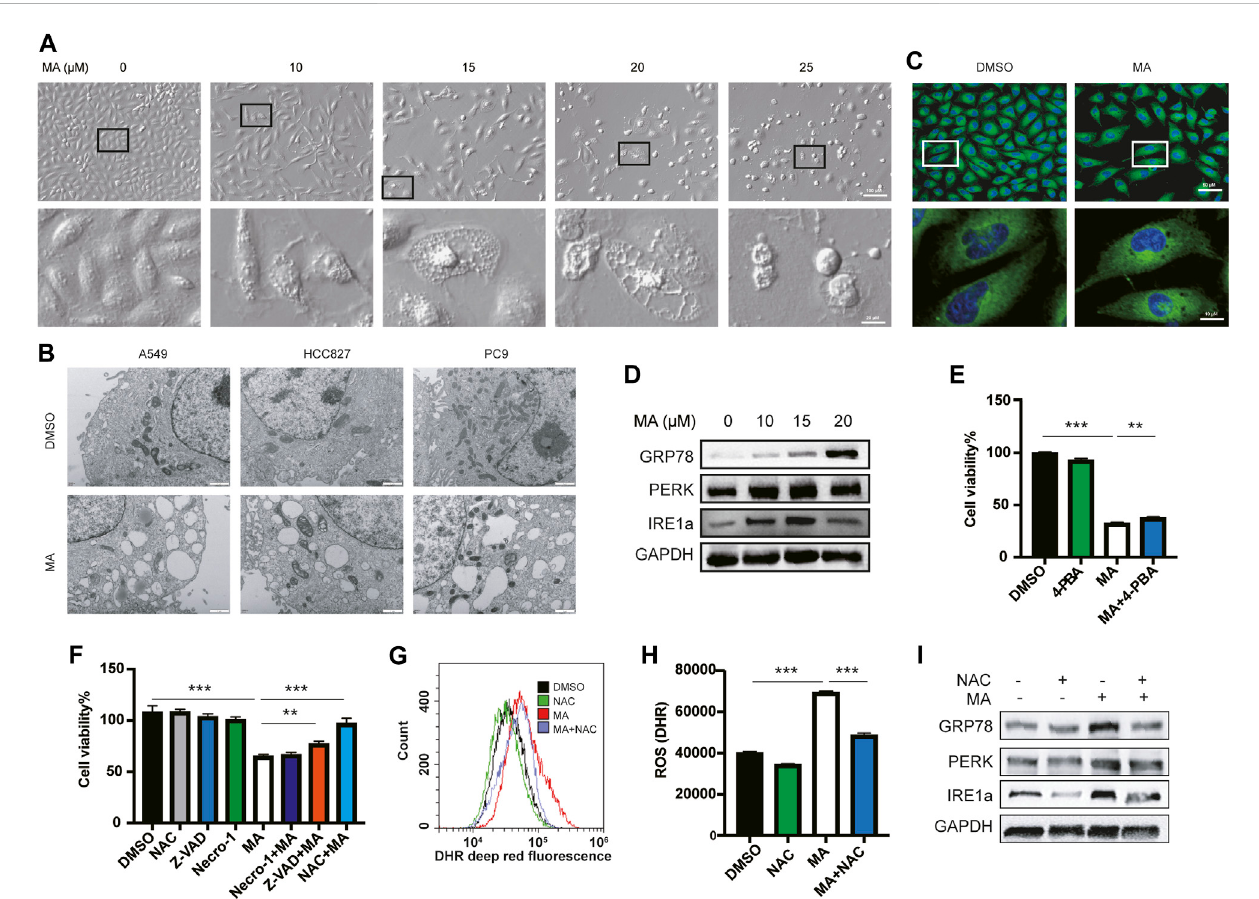
FIGURE 2 MA causes ERvacuolation throughoxidativestress. (A) Representative morphological changes in A549 cells treated with differentconcentrations of MA. (B) Electron microscope analysis of A549, HCC827, and PC9 cells treated with MA. (C) ER-tracker staining of A549 cells. (D) MA-activated ER stress-related markers were examined by western blot. (E) 4-PBA alleviated MA-suppressed cell proliferation, as shown by CCK-8 detection. The concentration of 4-PBA and MA were 500 μ M and 15 μ M, respectively. (F) Cell viability analysis of A549 cells co-treated with MA and several cell death inhibitors. Representative fl ow cytometry histogram (G) and quanti fi cation of DHR (ROS marker, deep red) (H) in A549 cells treated with single MA (15 μ M) or a combination of MA and NAC (1 mM). (I) As shown by western blot analysis, NAC inhibited MA-increased expression of ER stress-related markers. ** p < .01, *** p <